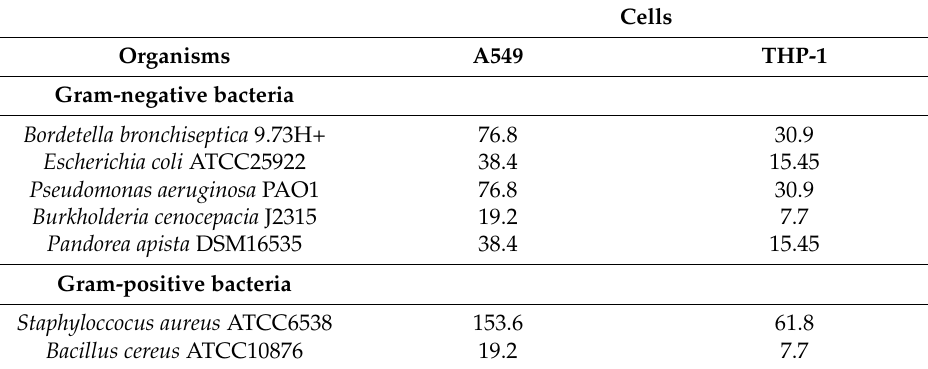
Table 3. Selective Indices (SI) of compound 11 against different cell